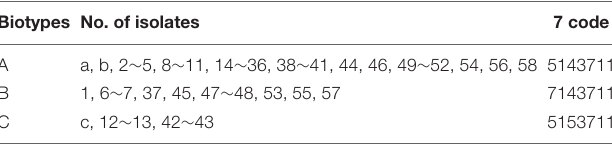
TABLE 5 | Biochemical profiles of 58 E. faecalis isolates.